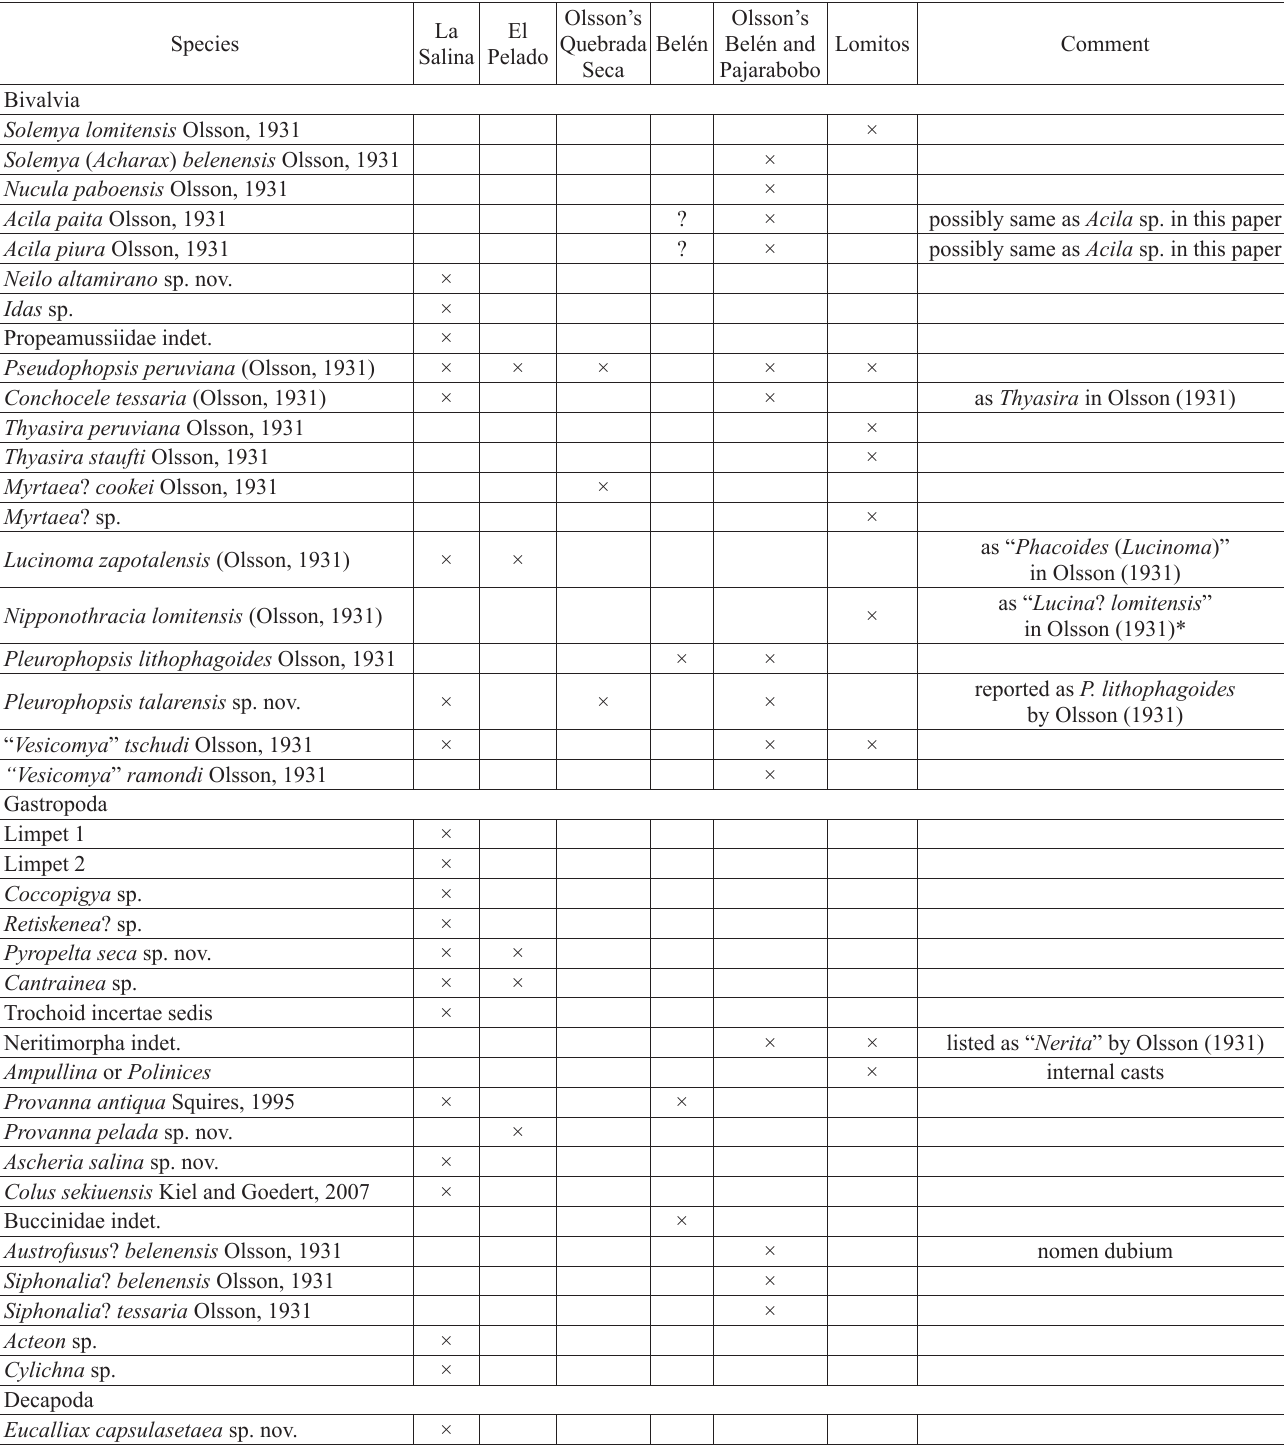
Table 2. List of species from the lower Oligocene seep carbonates in northern Peru; * includes most likely also the “ Cytherea ” and “large Cypri- na–Isocardia -like shells” listed by Olsson (see Kiel